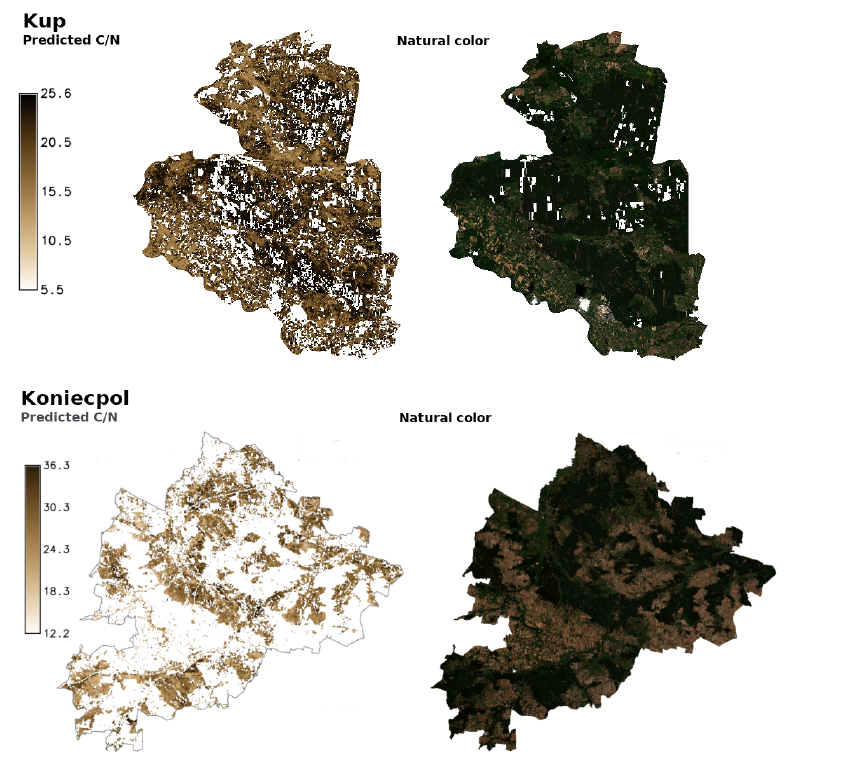
Figure 2. Predicted C/N ratio and natural colour composition for comparing the forest areas.